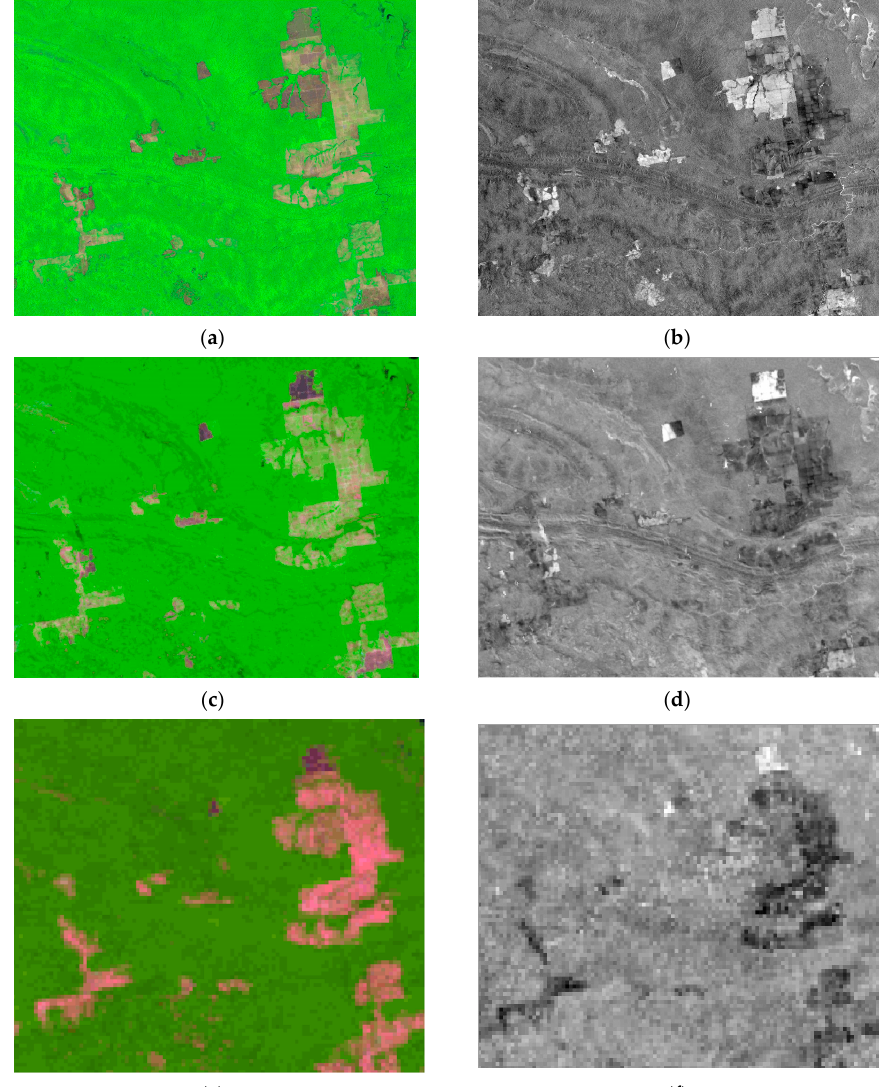
Figure 3. Example of burned areas showed in the sensors images analyzed in this work in purple in the left panel and in bright spots in the right panel: ( a ) R(6) G(5) B(4) OLI image and the corresponding ( b ) shade fraction image; ( c ) R(SWIR) G(NIR) B(RED) PROBA-V image and the ( b ) shade fraction image; ( c ) R(SWIR) G(NIR) B(RED) PROBA-V image and the corresponding ( d ) shade corresponding ( d ) shade fraction image; and ( e ) R(I3) G(I2) B(I1) VIIRS image and the fraction image; and ( e ) R(I3) G(I2) B(I1) VIIRS image and the corresponding ( f ) shade fraction image. corresponding ( f ) shade fraction image. These images show the characteristics of the spatial and These images show the characteristics of the spatial and temporal resolutions of those temporal resolutions of those sensors.